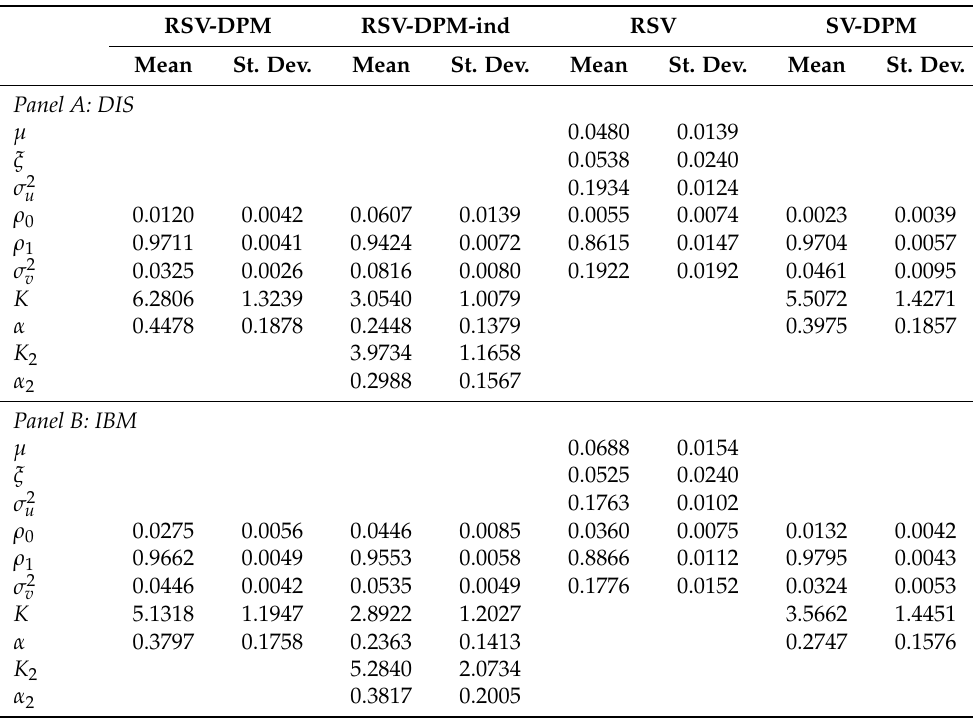
Table 2. Posterior estimates of the RSV-DPM, RSV-DPM-ind, RSV and SV-DPM